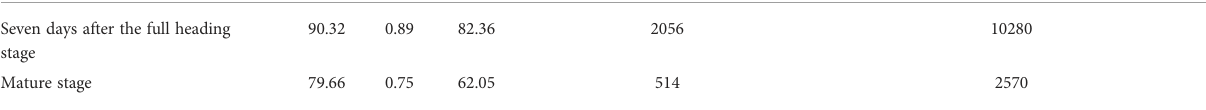
TABLE 7 In fl uence of sampling period on model